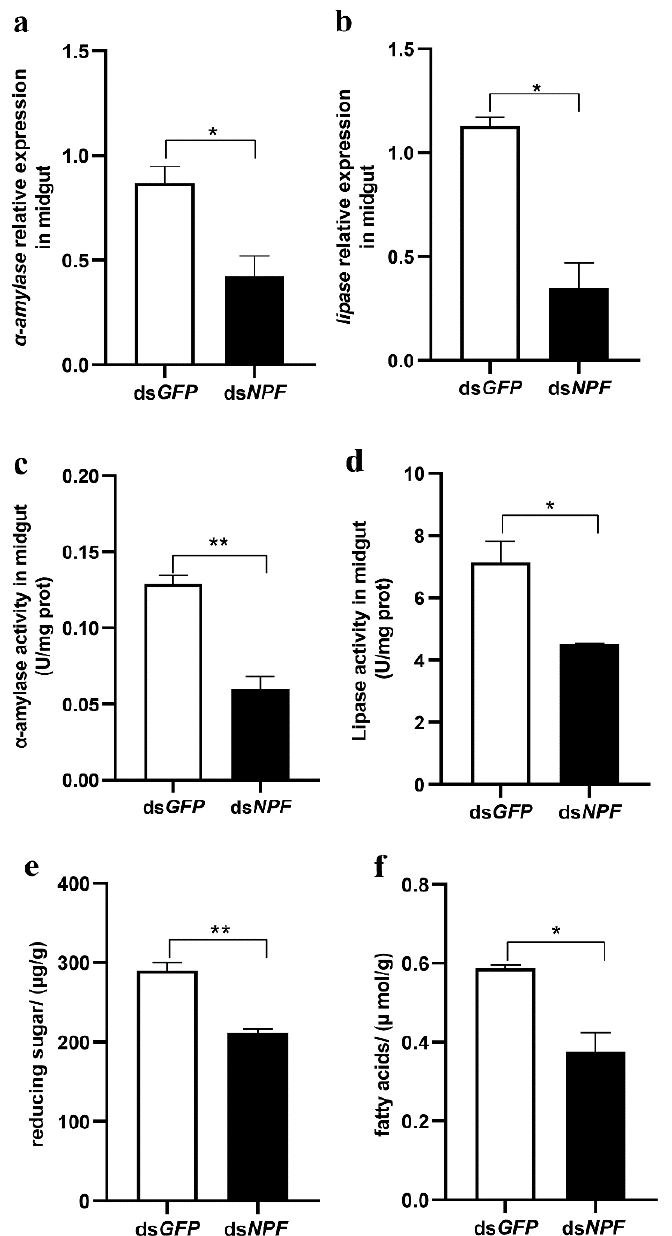
Figure 3. Roles of NPF with regard to larval digestion enzymes. ( a – d ) The expressions and enzyme activities of midgut α -amylase and lipase, respectively, in 5th instar larvae with NPF and GFP knockdown for 24 h. ( e , f ) The content of reduced sugars and fatty acids in the midgut of 5th instar larvae with NPF and GFP knockdown for 24 h. Each treatment was repeated 3 times with a minimum of 10 individuals each repeat. Bars represent the mean ± SE, * p < 0.05, ** p < 0.01.